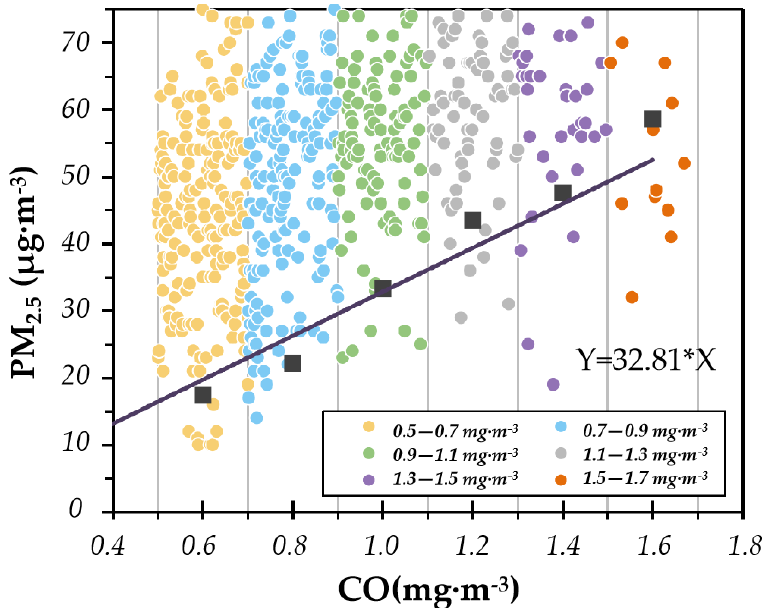
Figure 2. Scatter plots of hourly PM 2.5 and CO concentrations during 12:00–2:00 pm (local time in China) in the winter of 2015 with clean air quality, non-precipitation, and low oxidation capacity. The different colors represent the various CO concentration bins. Black squares refer to the estimated value of R PPM/CO within CO bins. The solid black line is the fitting line of the black squares, and the slope of 32.81 is the ultimate R PPM/CO . Table 1. Comparisons of SPM and SPM/PM 2.5 between our STAEA estimation and the previous measurements with concentrations ( µ g · m − 3 ) of PM 2.5 with the SIA, SOA, and SPM.